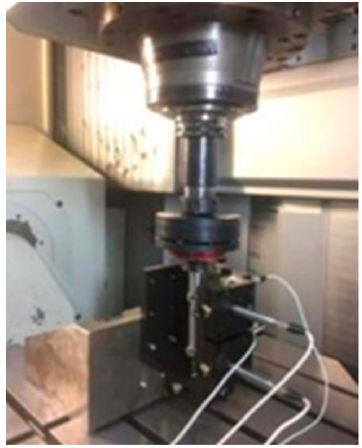
Figure 13. Developed the test on site